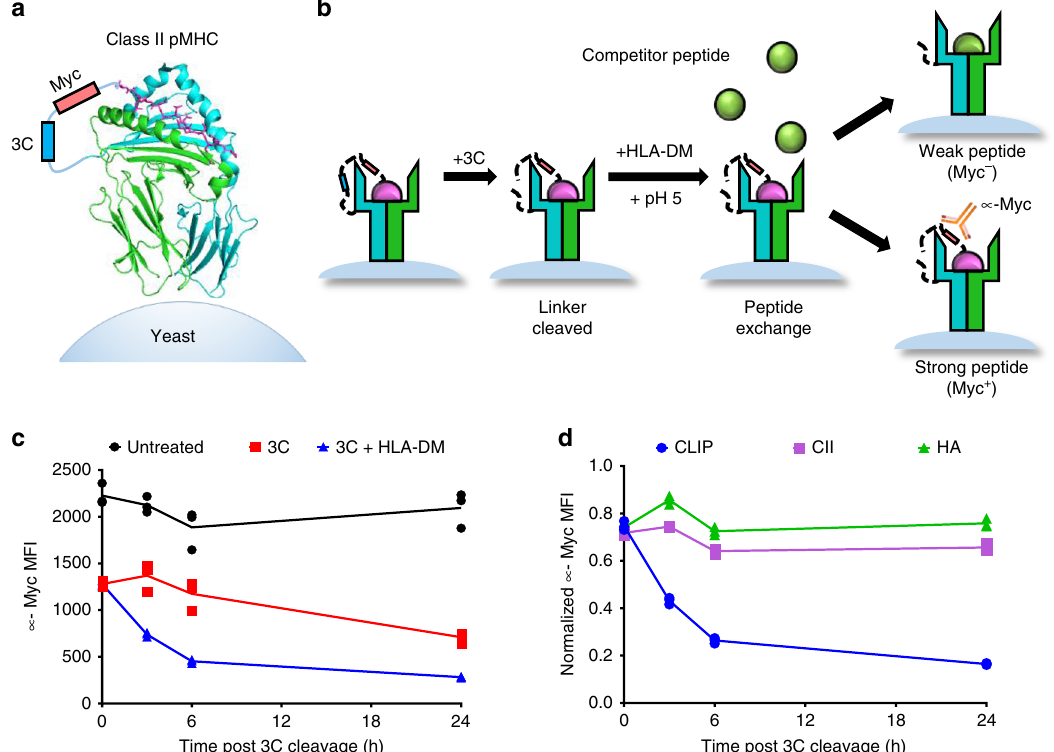
Fig. 1 Design and validation of a yeast-display platform to identify peptide binding to a co-expressed class II MHC. a Structural representation of HLA- DR401 (PDB 1J8H) modi fi ed to encode a 3C protease cleavage site and Myc epitope tag within the linker connecting the peptide and MHC β 1 domain. b Schematic of validation protocol, including linker cleavage with 3C, peptide exchange at low pH in the presence of HLA-DM and high-af fi nity competitor peptide, and quanti fi cation of remaining bound peptide with an anti-Myc antibody. c Time course of mean fl uorescence intensity (MFI) of a fl uorescently labeled anti-Myc antibody for HLA-DR401-CLIP 81-101 -encoding yeast without treatment (Untreated), with linker cleavage (3C), or with linker cleavage and peptide exchange (3C + HLA-DM), as determined by fl ow cytometry. d Comparison of peptide retention for HLA-DR401-CLIP 81-101 , -CII 261-273 , or -HA 306- fl ow cytometry and normalized to MFI before treatment. For each 318 -encoding yeast with linker cleavage and peptide exchange, as determined by construct, n = 3 aliquots were treated independently and measured for each time point and condition. Statistical evaluation was performed by repeated measures two-way ANOVA with Dunnett ’ s test for multiple comparison within treatment conditions (3 degrees of freedom, F = 54 in 1 C and F = 504 in 1D), or Tukey ’ s test for multiple comparisons across treatment conditions (2 degrees of freedom, F = 312 in 1 C and F = 2366 in 1D). Source data are provided as a Source Data fi